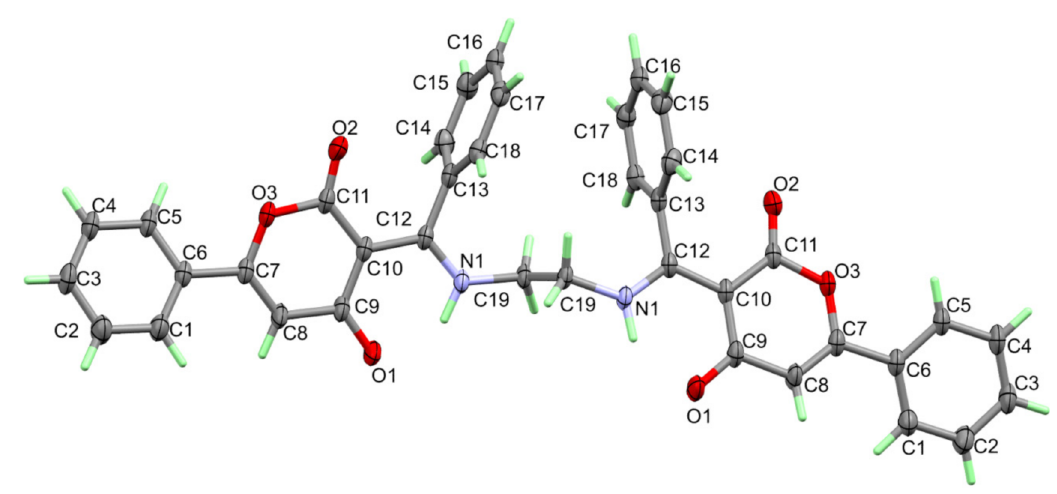
Figure 2. Structure of compound 1 with atom numbering drawn using 30% probability level for thermal